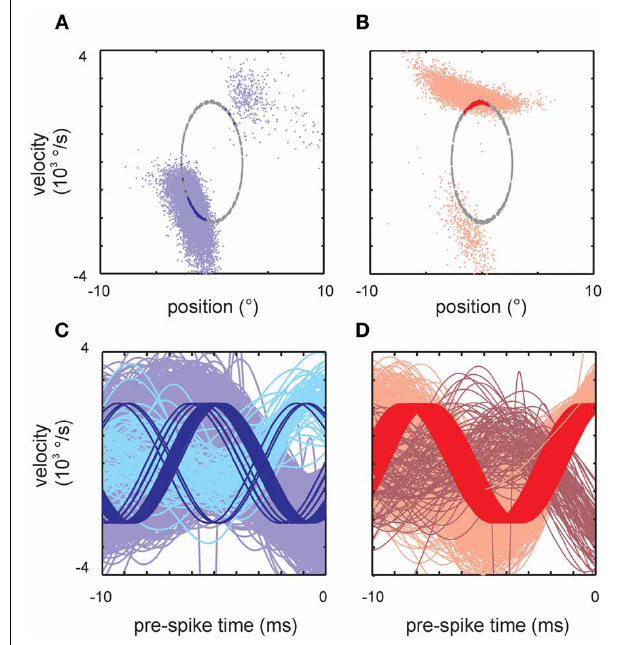
FIGURE A2 | Non-predictability of responses to simple stimuli from complex stimuli. (A,B) Responses to sine waves (on the ellipsoid track through the 2D kinematic space) and band-pass limited white noise of two example cells. (A) Primary afferent (SA, cell 16) that responded to the sine wave when entering both lobes as characterized by the broad-band stimulus. Such predictability was only seen in 2 cells (B) Another cell (RA, cell 11) did not respond when the sine wave traversed the second lobe (seen in 6 cells). (C,D) Same data but now plotted to reveal the velocity trajectory of broad-band and sine wave stimuli within the 10ms interval preceding the spike. (C) Same cell as ( A) . The broad-band trajectories landing in the two lobes are depicted in light and medium blue color. The spike triggered sine wave trajectories are plotted in dark blue. (D) Same as (C) , but for the cell shown in (B) (light and medium red: broad-band trajectories; dark red: sine wave trajectories). Here, in contrast to (C) , sine waves landing in the lower lobe never elicit spikes.